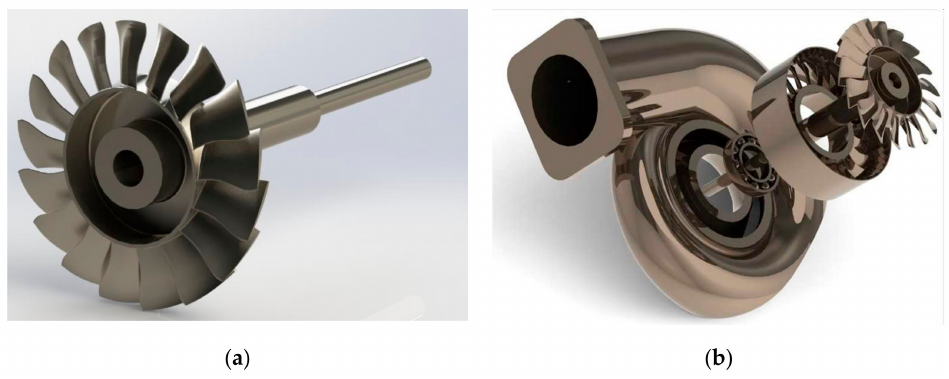
Figure 33. ( a ) Optimized blade design and ( b ) 3D model of the axial